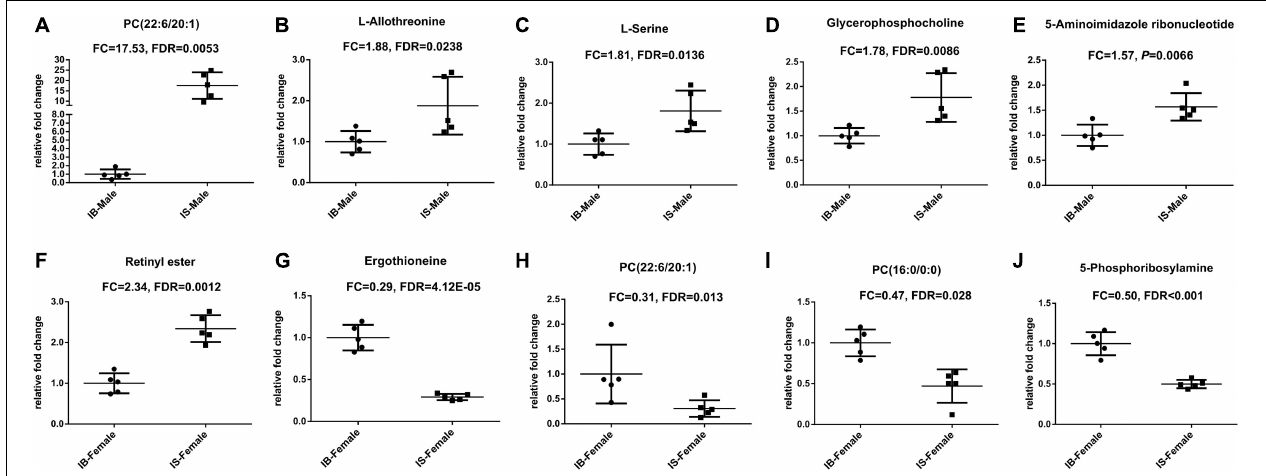
FIGURE 3 | Scatter plots of differential metabolites with FC ≥ 1.5 or FC ≤ 0.5 in comparison groups. (A–E) : Differential metabolites between IS-MALE vs. IB-MALE; (F–J) : Differential metabolites between IS-FEMALE vs. IB-FEMALE. The sample size is 5 in each group of worm